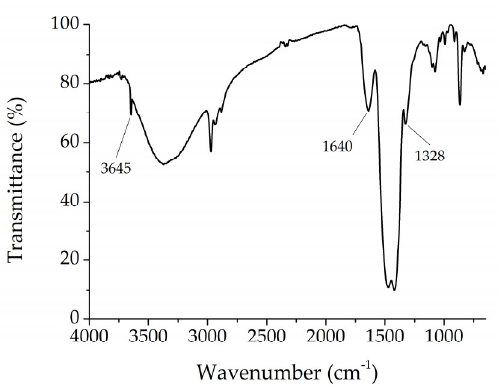
Figure 2. μFT-IR spectrum acquired after three minutes from the beginning of the analysis showing the reaction pathway of carbonation process for 2BU.